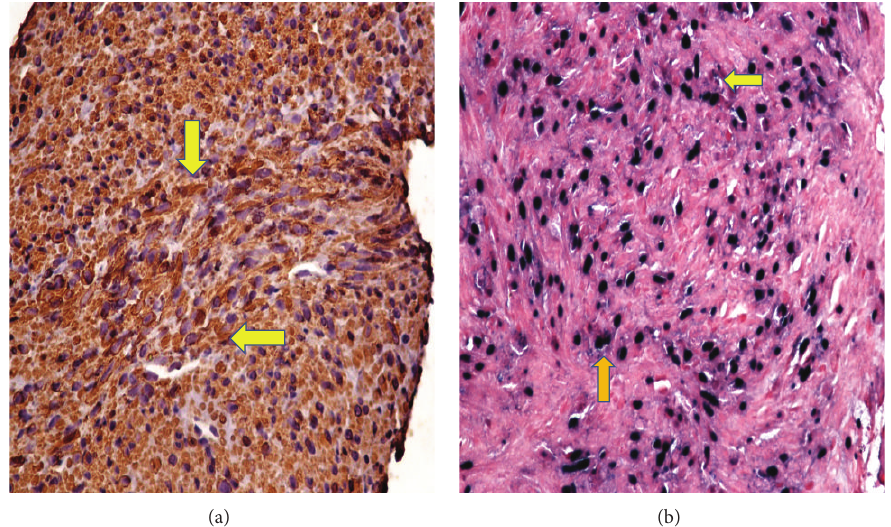
Figure 4: Immunohistochemical staining of the hepatic tumor. (a) Cytoplasm of the spindle shaped tumor cells stain positive for smooth muscle actin. (b) Neoplastic cells stain positive with nuclear in situ hybridization for